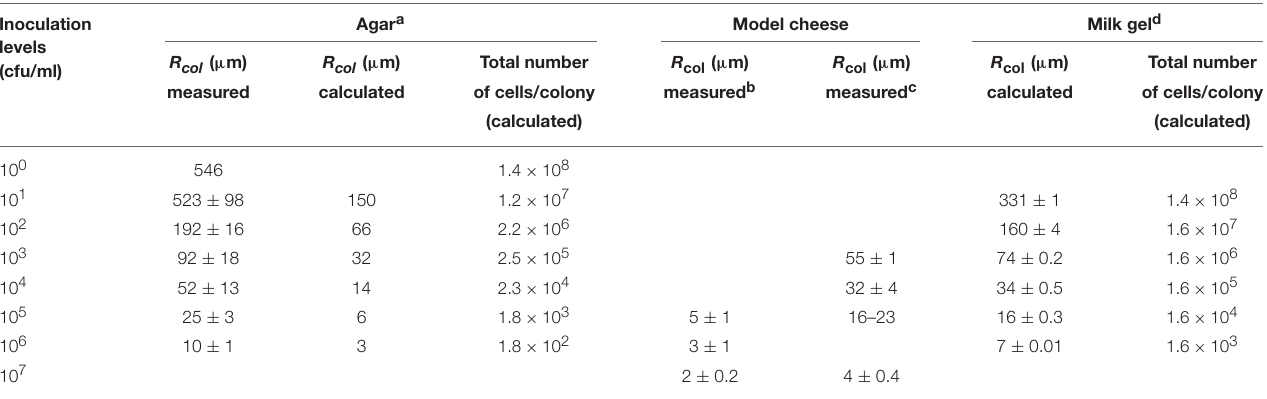
TABLE 2 | Size of colonies (calculated by microcalorimetric method or measured from micrographs) as a function of different inoculation levels of two different species of lactic acid bacteria grown in agar, milk gels, or in model cheese. Inoculation levels